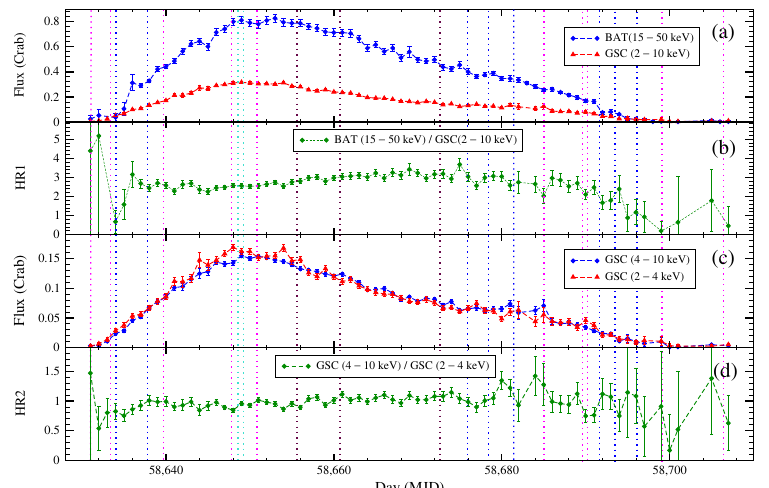
Figure 2. The variation of ( a ) Swift/BAT flux in 15–50 keV (blue) and 2–10 keV MAXI/GSC (red) fluxes; ( b ) hardness ratio (HR1) of BAT (15–50 keV) and GSC (2–10 keV) fluxes; ( c ) MAXI/GSC fluxes in 4–10 keV (blue) and 2–4 keV (red); ( d ) hardness ratio (HR2) of 4–10 keV to 2–4 keV MAXI/GSC fluxes. Vertical lines indicates dates of the observation IDs used in the work. Magenta indicates Swift/XRT, blue indicates NICER, and maroon indicates NuSTAR observation IDs. Turquoise indicates the epoch of the AstroSat observations for timing